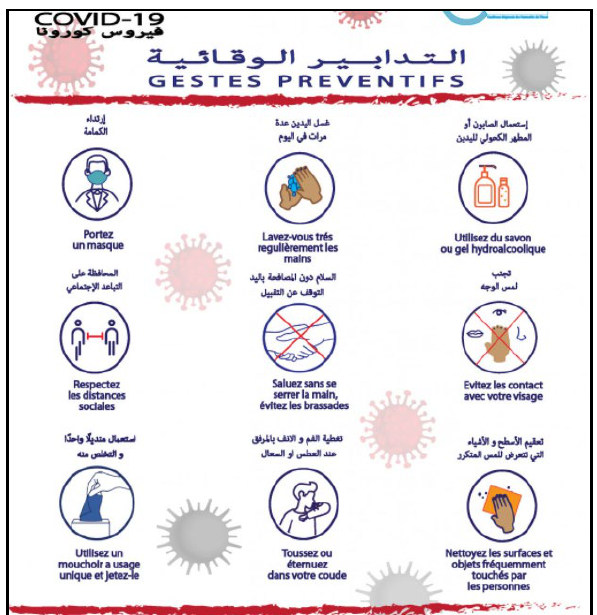
Figure 6. Shitsuke